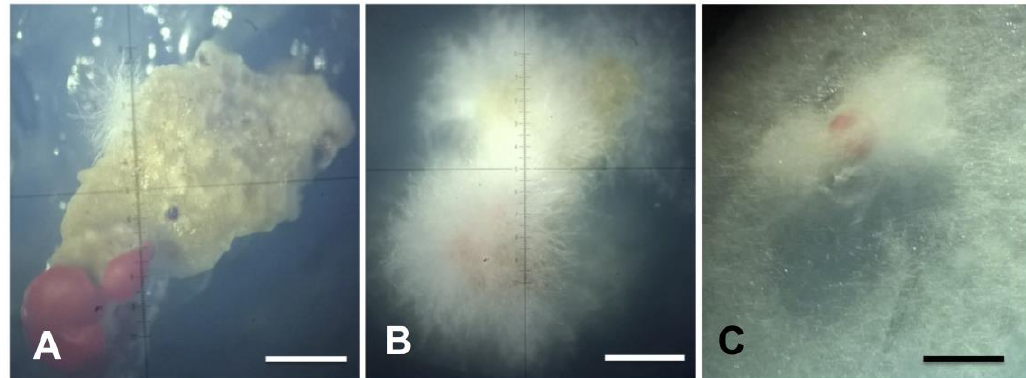
Figure 1. Endolichenic Xylaria growing on podetia of Cladonia curta . ( A , B ). Stereoscope (zoom 1.6×); ( C ). Stereoscope (zoom 3.2×); ( A ). Initial growth of hyphae on podetium after four days of inoculation; ( B ). Appearance of hyphae 18 days after isolation; ( C ). Formation of the mycelium in culture medium MS.—Scale bars ( A – C ) = 500 µm.